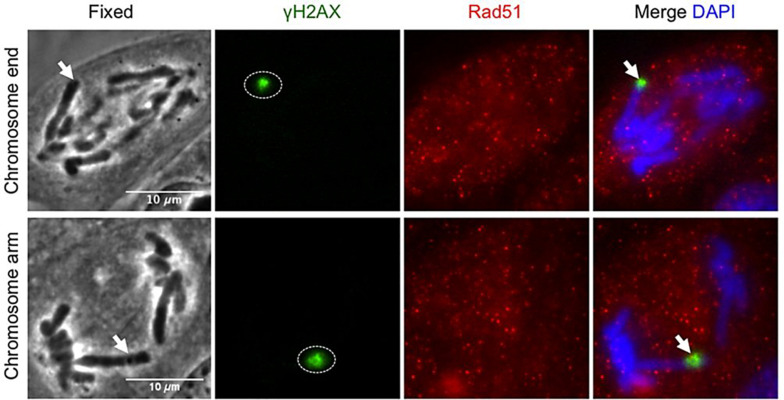
Homologous repair protein Rad51 does not get recruited to anaphase DNA breaks. Postfixation performed 5 min after laser irradiation to a single chromosome end and chromosome arm. Repair proteins are detected with anti-γH2AX (green), anti-Rad51 (red), and co-stained with DAPI (blue). Arrow points to microirradiated chromosome site. γH2AX: phosphorylated-H2AX; Rad50: DNA repair protein Rad50. Scale bar = 10 μm. Reproduced with permission from Alcaraz Silva et al. (2013).